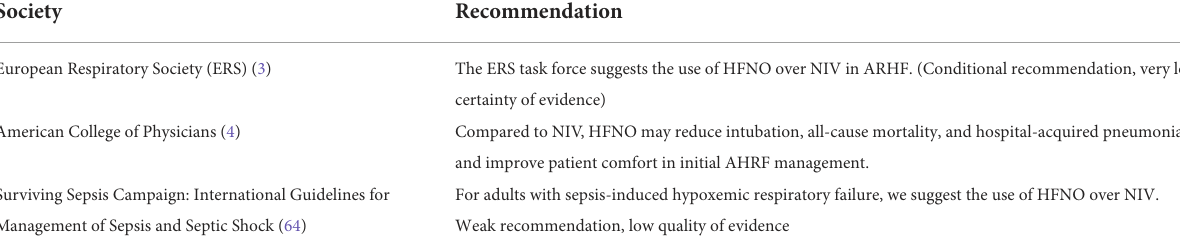
TABLE 4 Recommendations comparing high-flow nasal oxygen with non-invasive ventilation in acute hypoxemic respiratory failure. Society Recommendation European Respiratory Society (ERS) (3) The ERS task force suggests the use of HFNO over NIV in ARHF. (Conditional recommendation, very low certainty of evidence) American College of Physicians